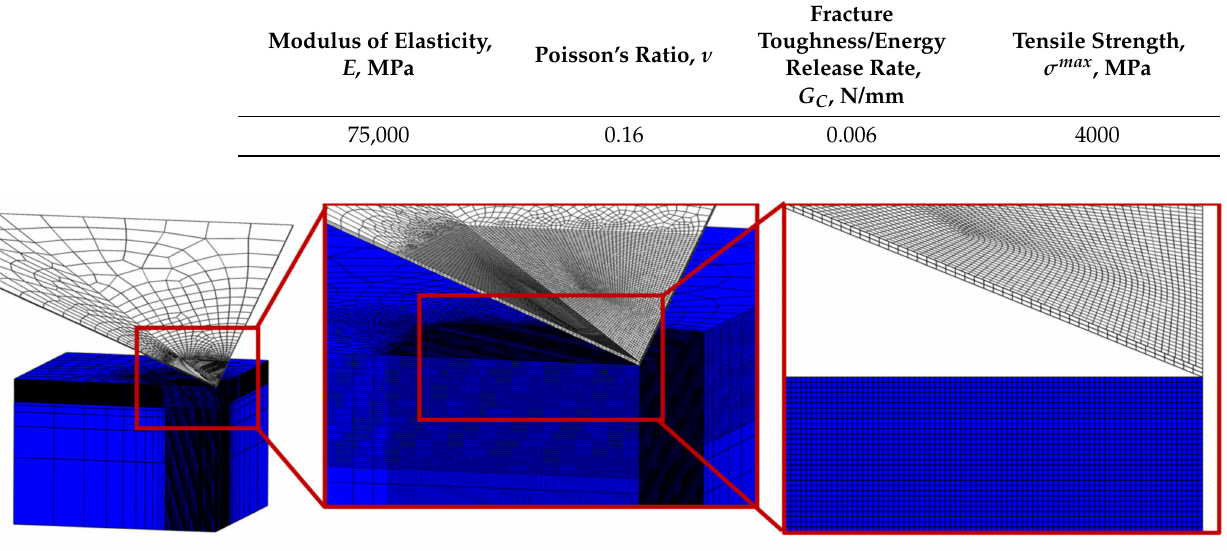
Figure 5. Mesh distribution on the indentation